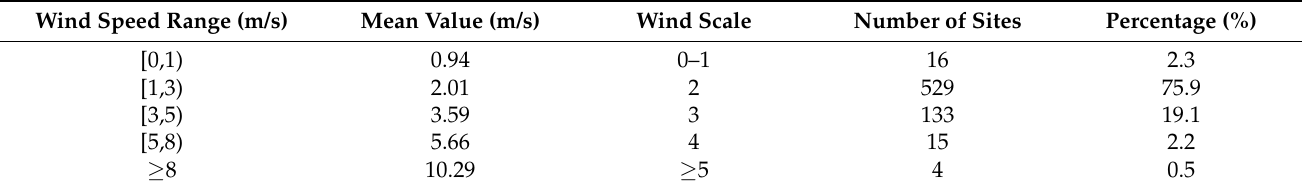
Table 2. The number of meteorological sites, percentage, mean value, and wind scale in each wind speed range. Wind Speed Range (m/s) Mean Value (m/s) Wind Scale